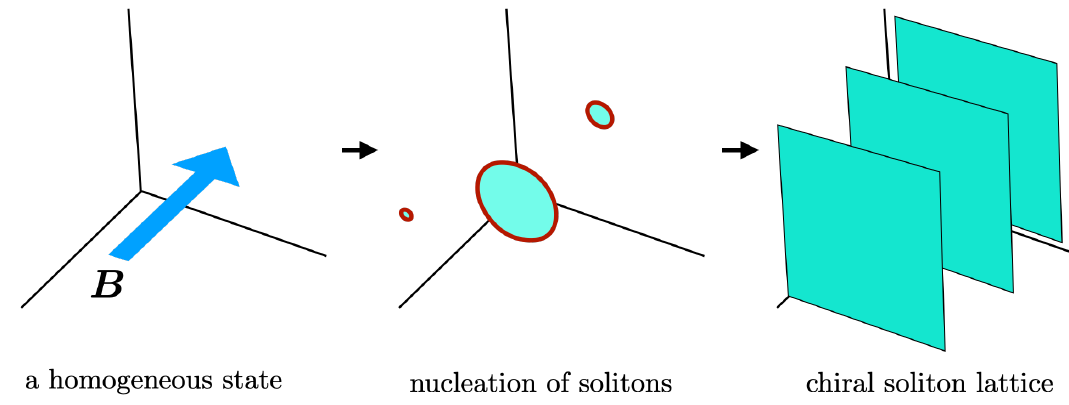
Figure 7 . Nucleation of solitons and formation of a